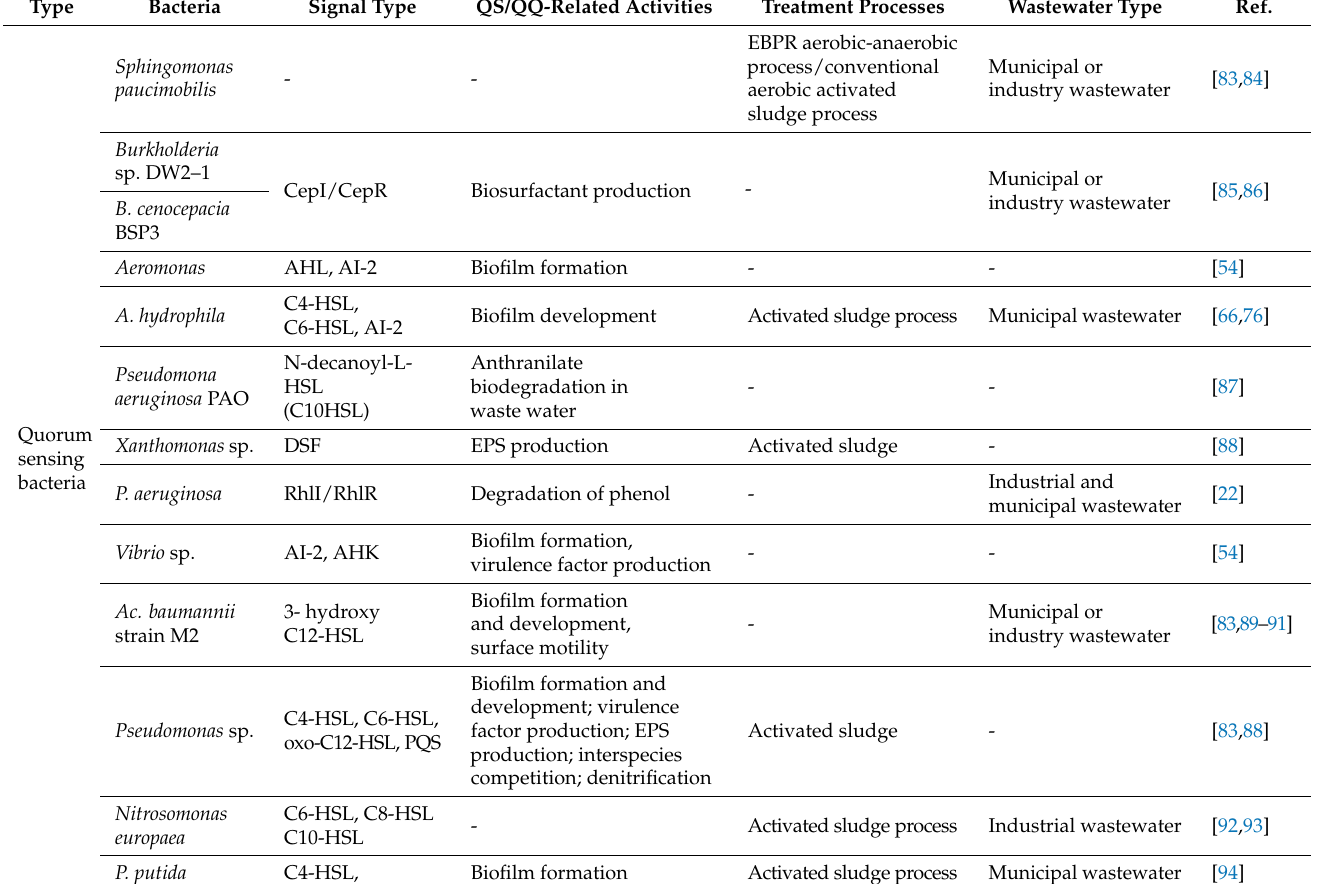
Table 1. QS and QQ bacteria involved in wastewater